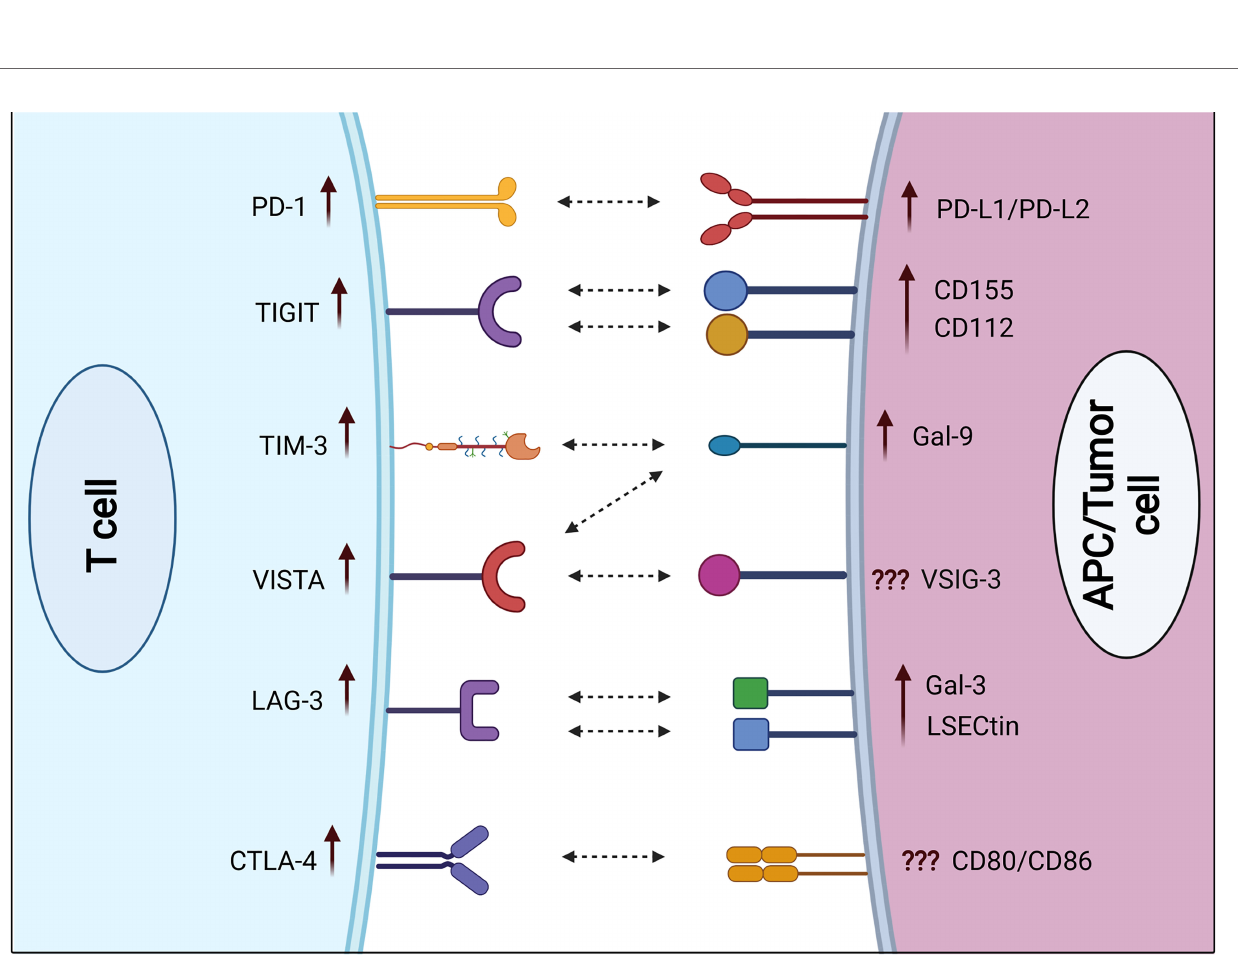
FIGURE 1 | Expression of immune checkpoint receptors on T cells and their respective ligands on APCs and/or cancer cells in severe COVID-19 patients. Some ICs including PD-1, TIGIT, TIM-3, VISTA, LAG-3, and CTLA-4 are upregulated on both CD4+ and CD8+ T cells in severe COVID-19 patients, compared with mild/ moderate patients. Various IC ligands including PD-L1, PD-L2, CD155, CD112, Gal-9, Gal-3, and LSECtin are upregulated on APCs in severe COVID-19